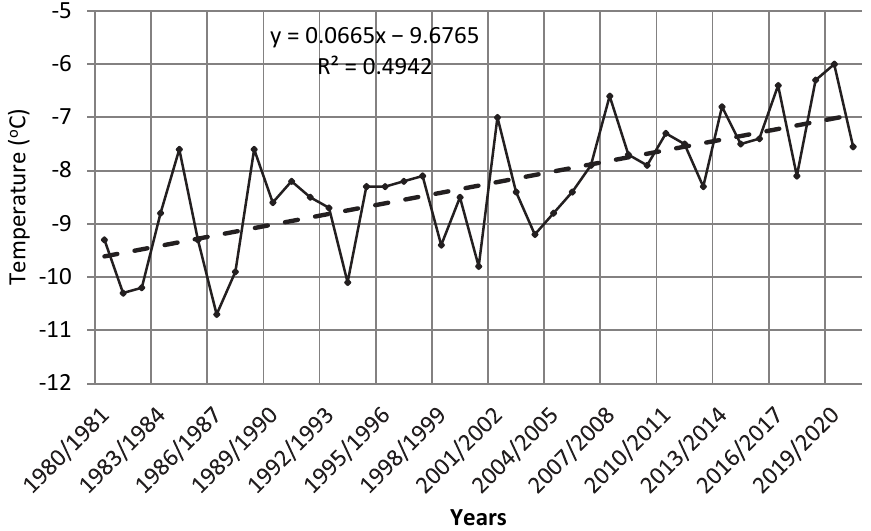
Figure 2. Long-term course of the mean annual air temperature ( ◦ C) in Yakutsk, 1981–2020. The Figure 2. Long ‐ term course of the mean annual air temperature (°C) in Yakutsk, 1981–2020. The dotted line indicates a linear trend. dotted line indicates a linear